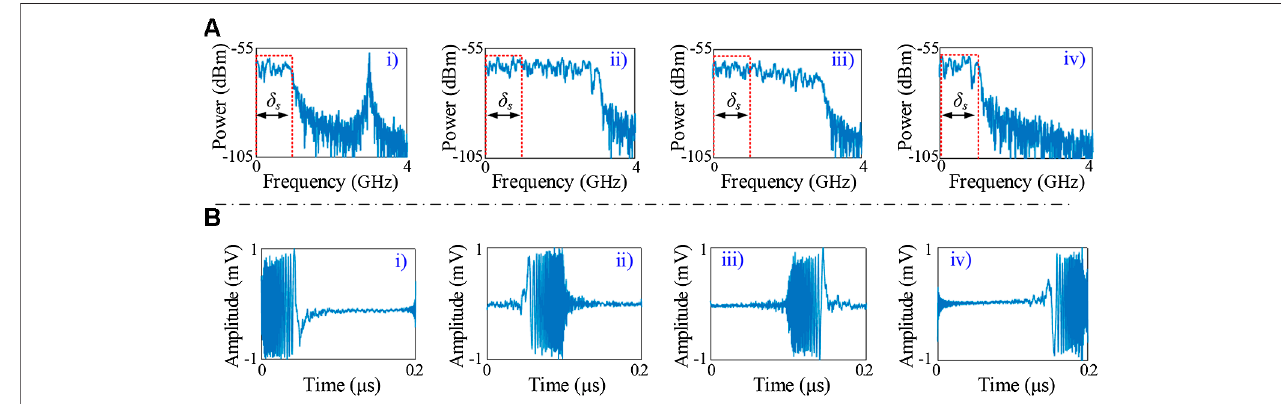
FIGURE 8 | (A) Spectra of the output signals processed by optical hybrids and electrical quadrature hybrids and (B) waveforms of channelized signals after low- pass fi lters, where the 4 GHz linearly-chirped signal has a 4 GHz center frequency.